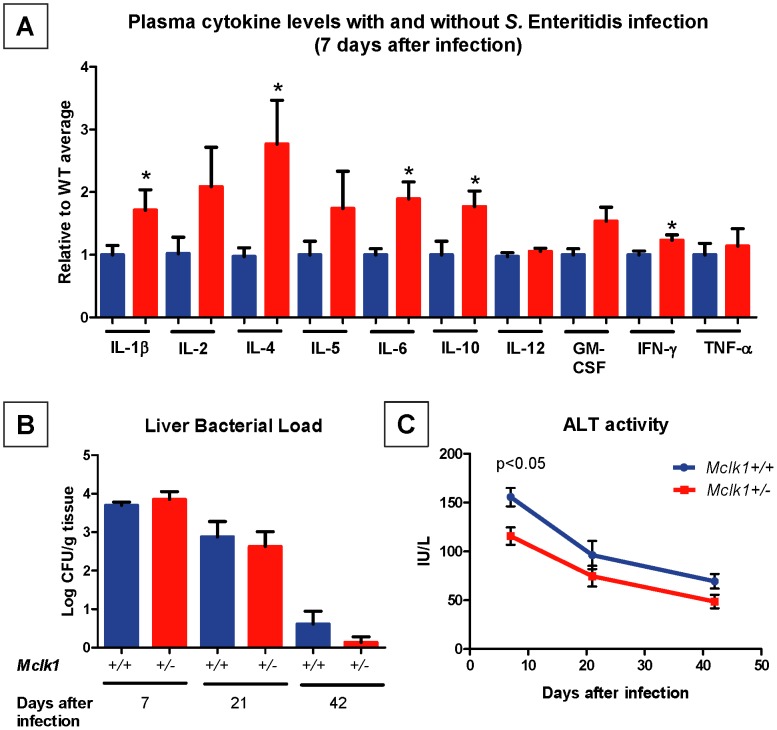
Enhanced immune response and lower tissue damage after Salmonella Enteritidis infection of Mclk1+/− mutants on the C57BL/6J background. A.Three months-old littermates of both genotypes were infected intravenously with 1800 CFUs per mouse, their plasma collected after 7 days and evaluated for cytokine levels. For each cytokine the values were normalized to the mean value measured for the Mclk1
+/+ control group. The sample size was 32–38 for each genotype. The asterisks represent p<0.05. B. Three months-old mice on the C57BL/6L background were allocated into 3 groups of 9–12 mice for each genotype. Each mouse was infected intravenously with 103 CFUs S. Enteritidis. Bacterial loads in liver were measured at days 7, 21 and 42 after infection. C. Plasma ALT activity was measured on day 7, 21 and day 42 after infection. 5–13 mice in each genotypic group at each time point were used, and the mean ± S.E.M. is shown. All experiments in this figure were carried out with even numbers of both males and females.